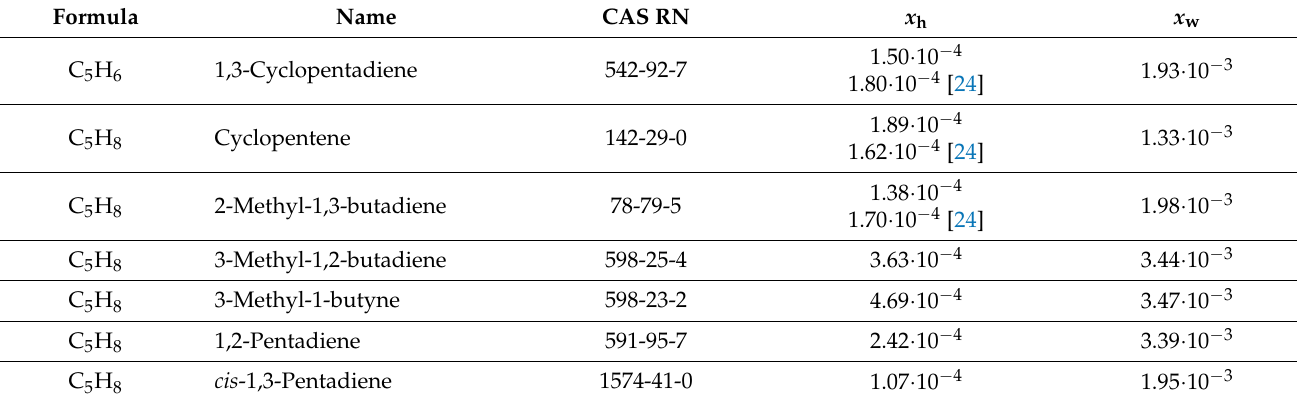
Table 1. Calculated mutual solubilities in hydrocarbon + water systems at 298.00 K, x h –mole fraction of hydrocarbon in water, x w –mole fraction of water in the hydrocarbon. Whenever possible the recommended experimental data taken from [23–25] and/or [26–37] are reported in the second row. Aqueous solubilities for six hydrocarbons at 298.15 K measured by Doh á nyosov á et al. [39] are included for comparison. For five of them, there was no prior experimental data. It should be noted that these data were not critically